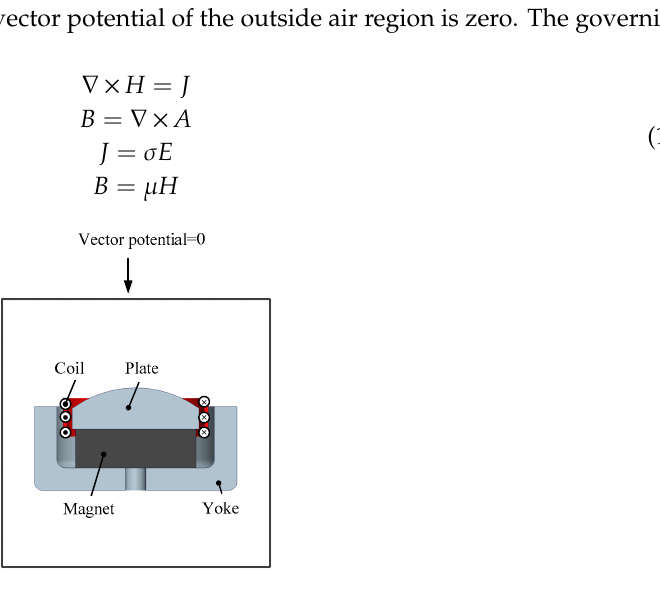
Figure 14. Electromagnetic system model and boundary conditions.